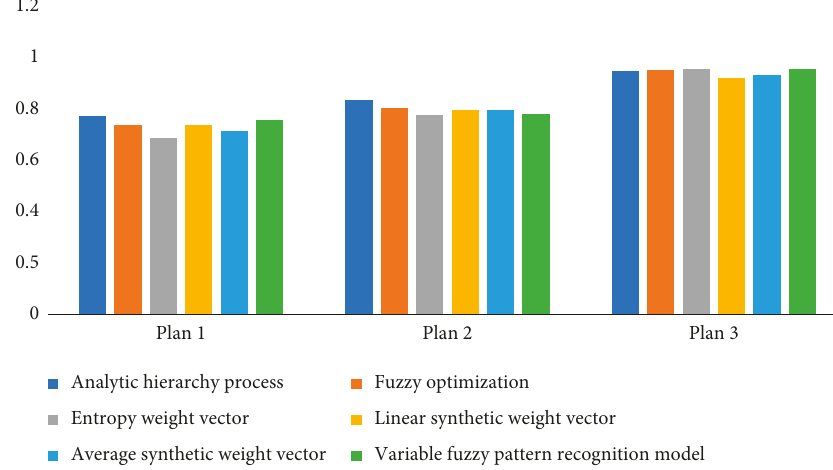
Figure 2: Comprehensive evaluation value of each program.